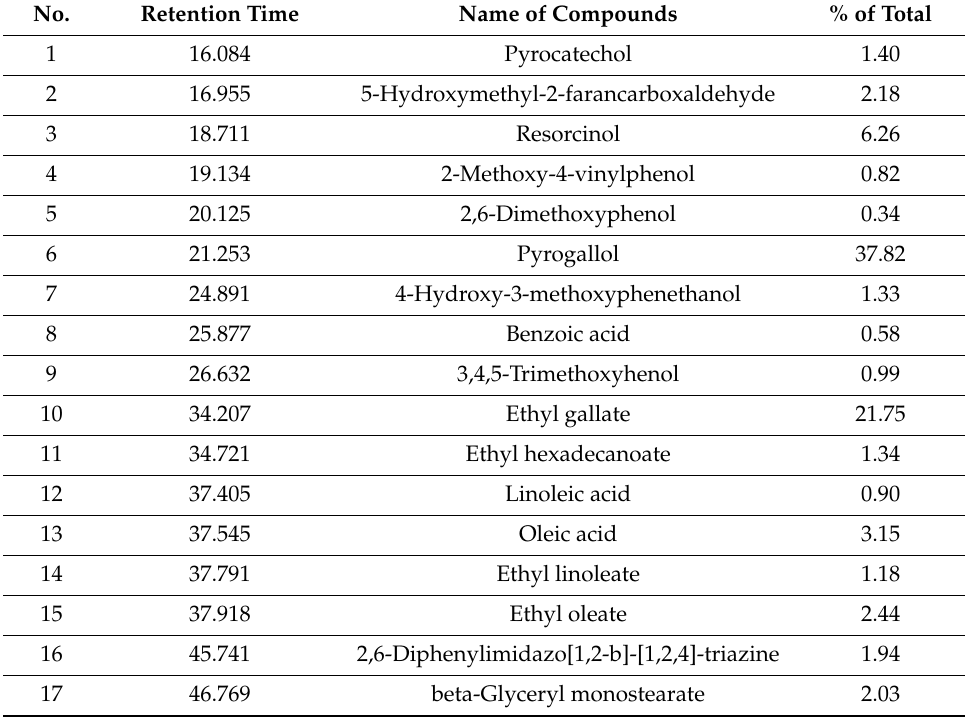
Table 5. Retention time, name, and percentage of the total of the enabling identification compounds from